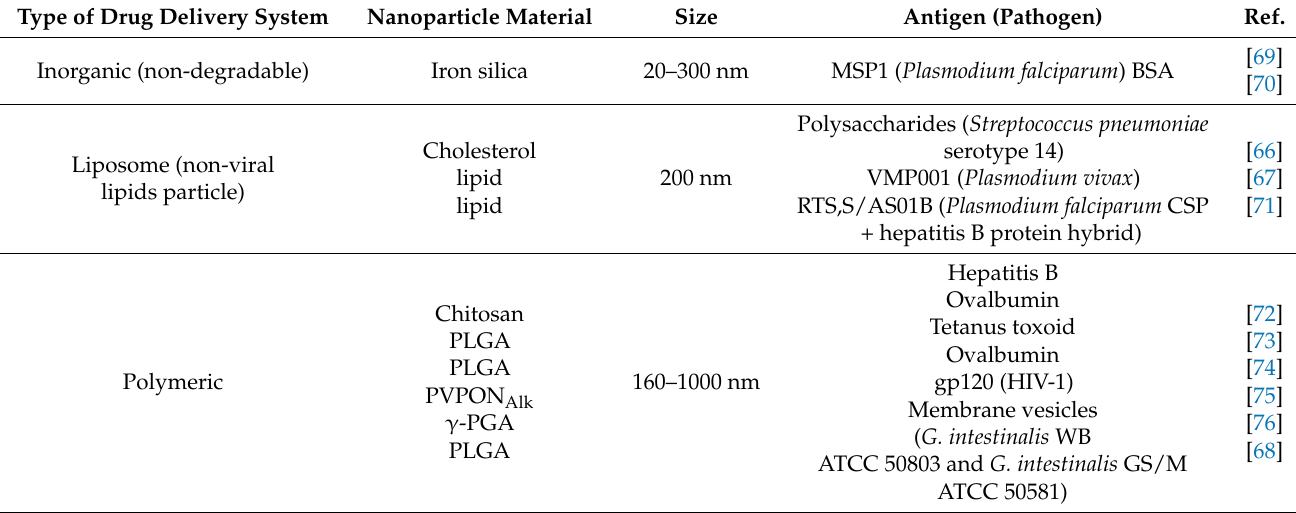
Table 2. Types of nanoparticles studied for antigen delivery in parasites and other microorganisms. Type of Drug Delivery